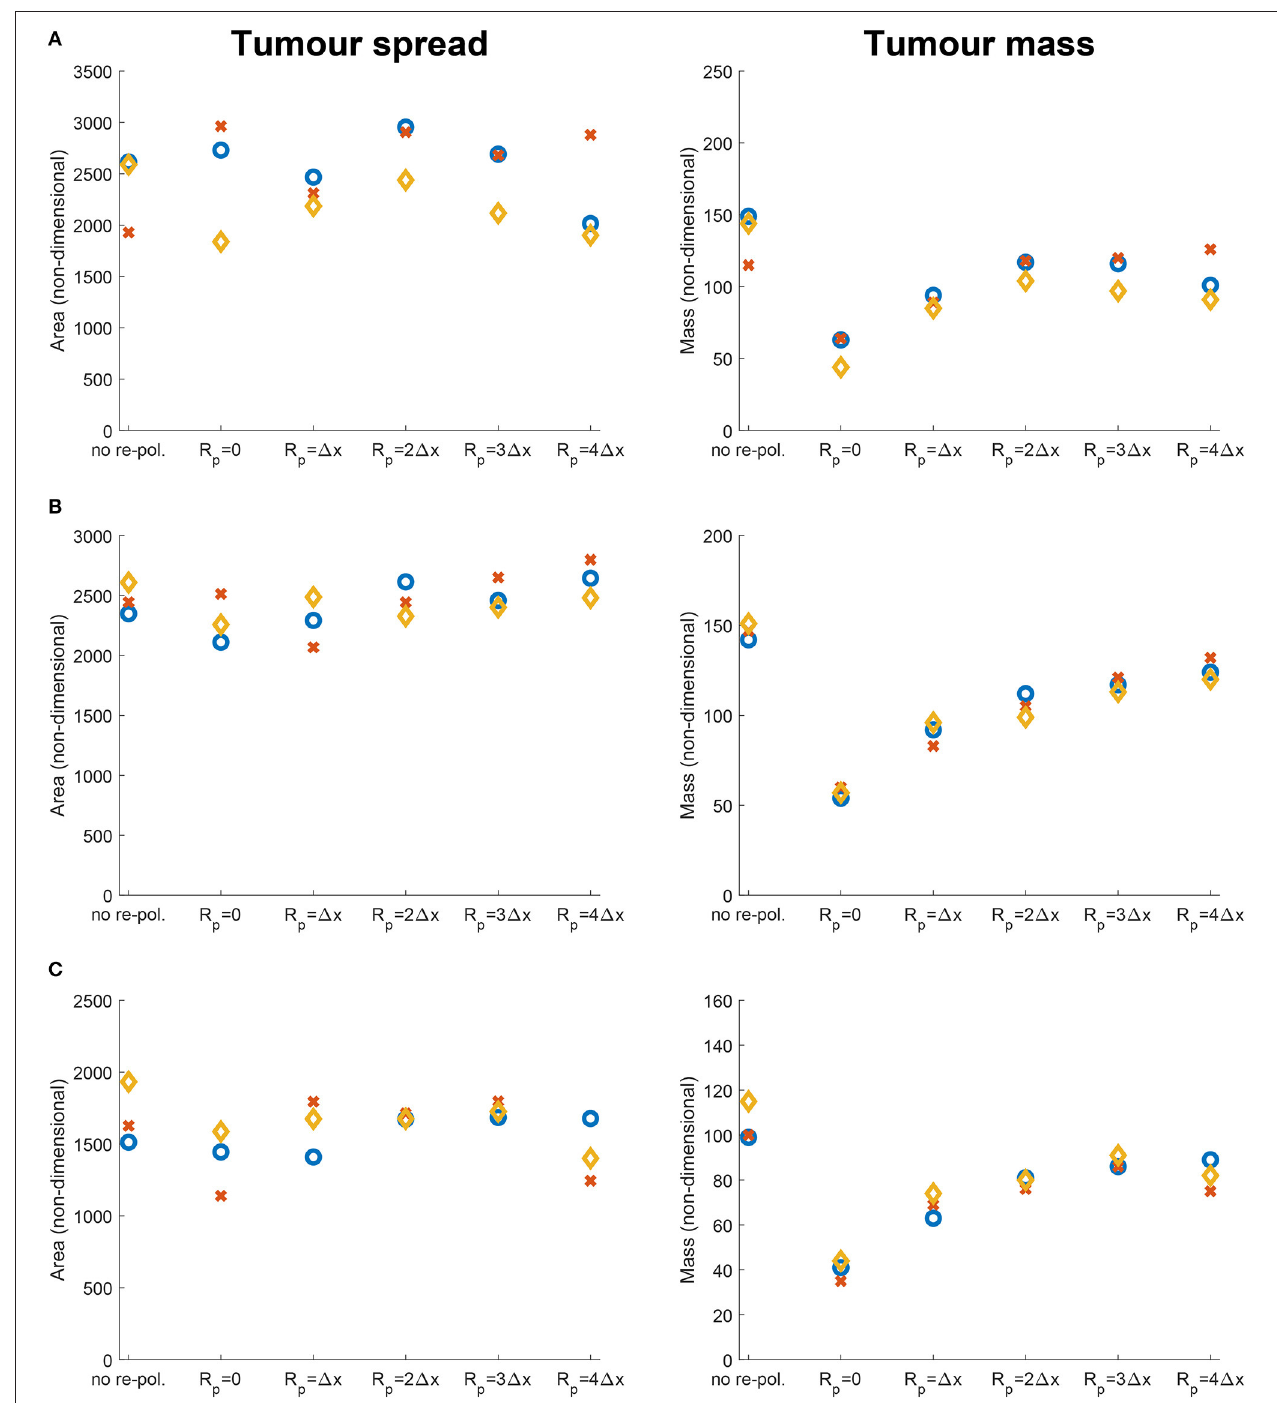
FIGURE 13 | Results of varying the radius of the re-polarisation domain R p ∈ { 0, 1 x ,2 1 x ,3 1 x ,4 1 x } with starting time t p = 0 in the absence of nutrients (i.e., σ ( x , t ) ≡ 0, ∀ ( x , t ) ∈ Y × [0, T ] and 9 p ( σ ) ≡ 1, 9 dc ( σ ) ≡ 1, 9 dM ( σ ) ≡ 1 and 9 M ( σ ) ≡ 1, ∀ σ and S M σ = 0). Left panel shows the change in the tumour spread and the right panel shows the change in tumour mass with respect to R p . Here the blue circles correspond to high ECM degradation rates by cancer cells ( β lc = 3.0, β Fc = 1.5, α c = 0.625), the orange diamonds to medium degradation rates ( β lc = 2.0, β Fc = 1.0, α c = 0.42) and the red crosses to low degradation rates ( β lc = 1.0, β Fc = 0.5, α c = 0.21). The environment controller β is set to (A) β = 0.75, (B) β = 0.7875, and (C) β =